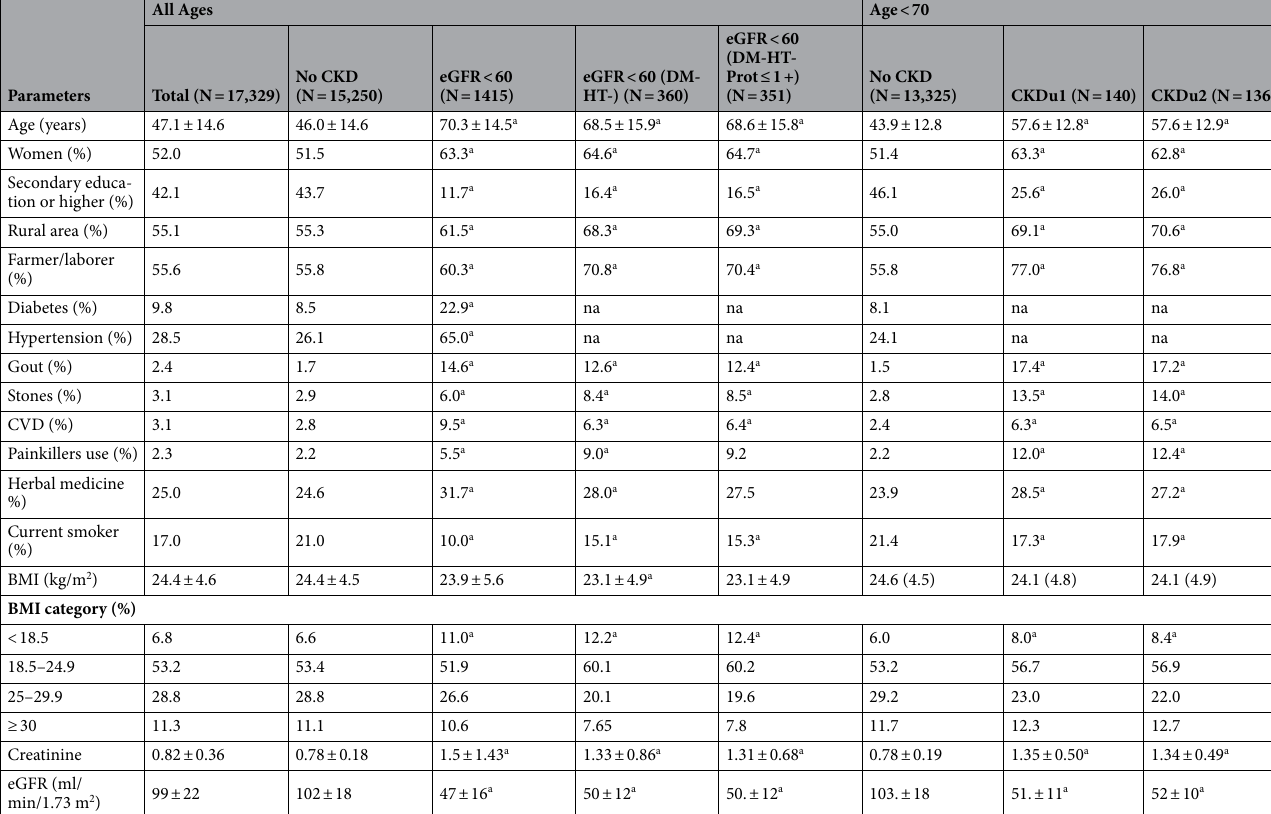
Table 1. Characteristics by kidney disease status (all age and under 70). Mean ± SD; eGFR < 60, decreased GFR-all causes; eGFR < 60 (DM-HT-), decreased GFR without diabetes or hypertension; eGFR < 60 (DM-HT- Prot ≤ 1 +), decreased GFR without diabetes, hypertension or heavy proteinuria; CVD, cardiovascular disease. a P < 0.05 versus no